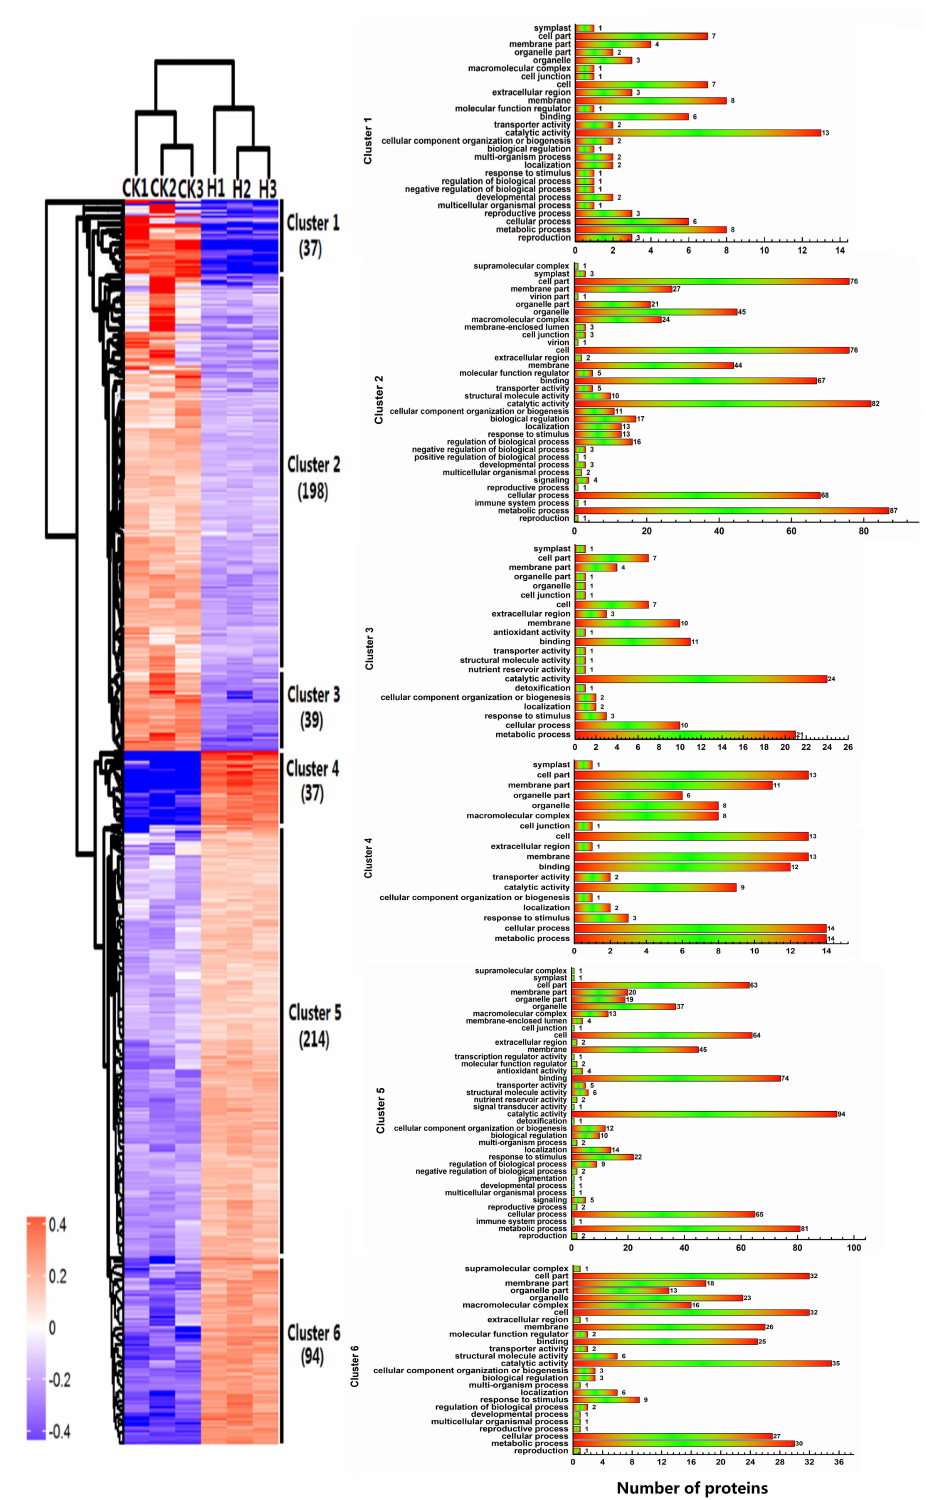
Figure 9. Hierarchical clustering analysis of the differential proteins in lettuce stem under high temperature. The left graph represents hierarchical clustering of proteins with differential abundance. The right graphs represent protein functional classification of the